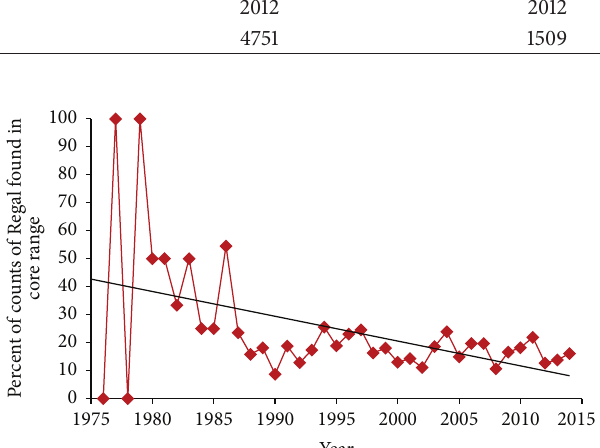
Figure 5: Percent of counts reporting Regal Fritillary each year in main Regal range, 1977–2014, with linear regression trend line. This declined significantly in both periods analyzed (Table 3).